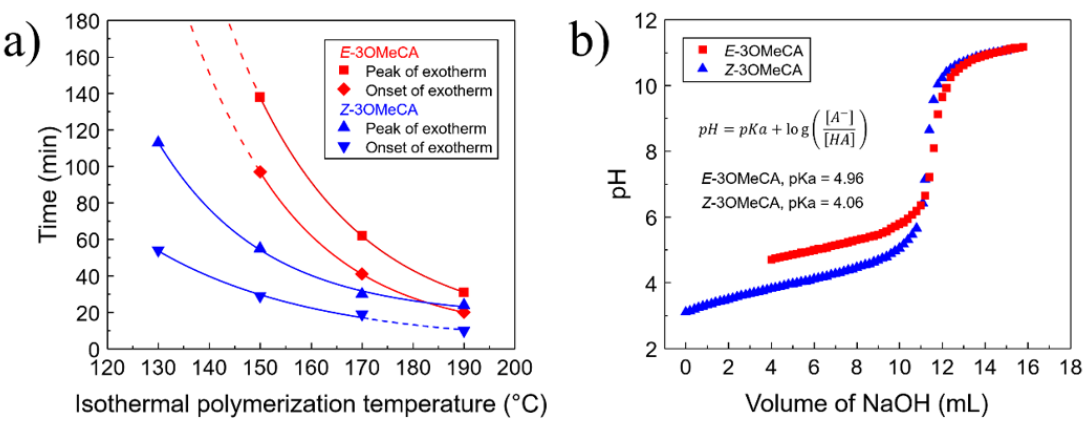
Figure 4. ( a ) Plot of time as a function of isothermal polymerization temperatures of peaks and onsets for the E -3OMeCA ( (cid:4) , (cid:95) , respectively) and Z -3OMeCA ( (cid:78) , (cid:72) , respectively) catalyzed polymerizations of PDP-a, catalyst concentration: 10% w / w. ( b ) Titration curves for each catalyst, E -3OMeCA ( (cid:4) ) and Z -3OMeCA ( (cid:78) ). Solvent: H 2 O:MeOH 90:10.